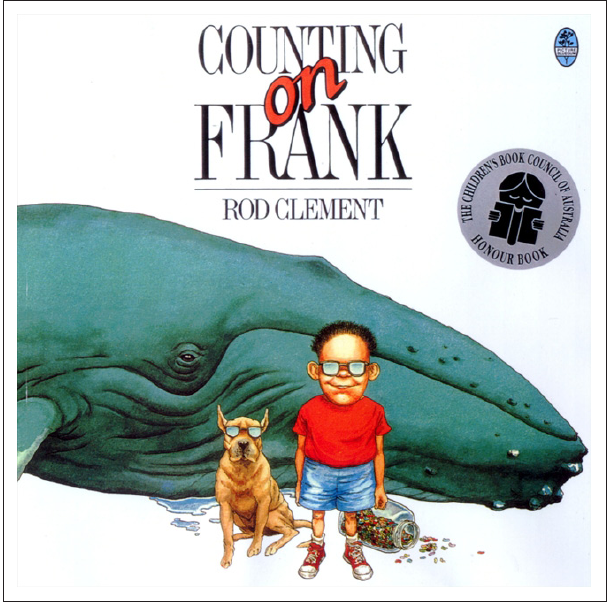
FIGURE 1: Book cover of Counting on Frank by Rod